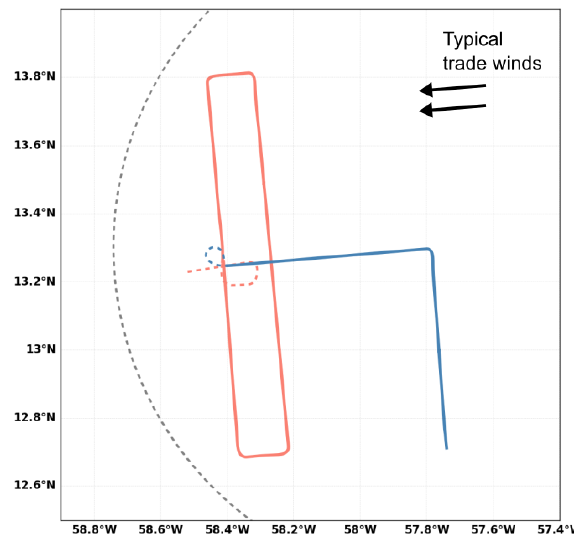
Figure 1. Schematic horizontal trajectory of the SAFIRE ATR 42 within the HALO circle (gray dashed lines) during EUREC 4 A. Ma- neuvers for alignment, ferry legs and other parts of the trajectory projection are not shown here. The R pattern is shown in red, and the L pattern is shown in